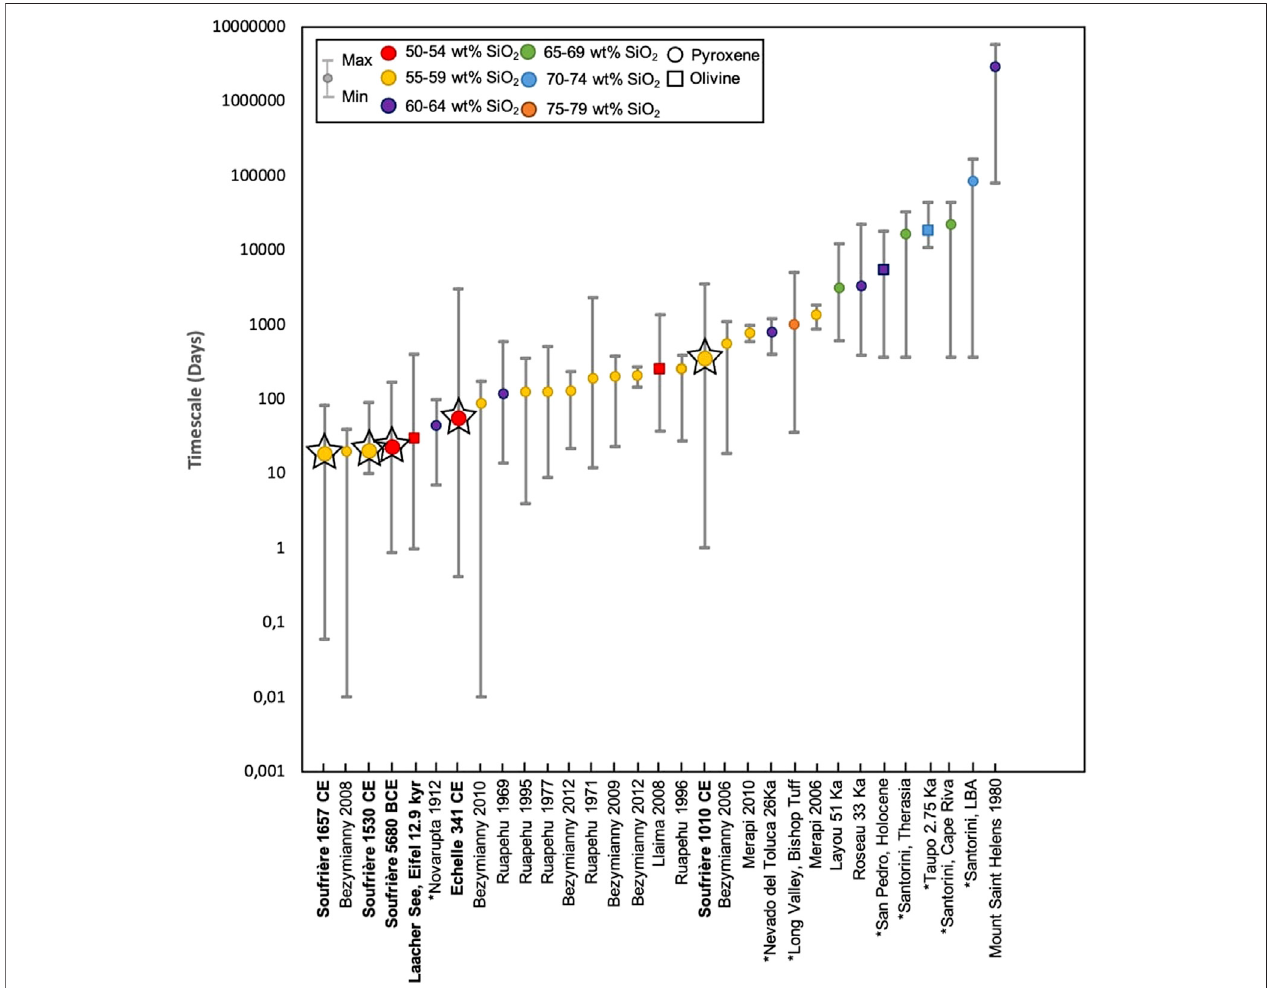
FIGURE 13 | Global database of diffusion timescales (adapted from Costa et al., 2020), for relatively evolved composition eruptions. The majority of studies are done on pyroxene with two examples of olivine studies. This shows the wide range of timescales that can be calculated through diffusion methods, from hours to centuries. Systems incomparable to La Soufriére are marked with an asterisk (*), these systems generally record the longest timescales and are more typically observed in evolved caldera forming systems. The1530 C.E., 1657 Cal. CE and 5680 Cal. BCE (whole rock estimated) eruptions record some of the shortest timescales for systems in a similar compositional range, with timescales most similar to Bezymianny and Novarupta, Alaska, which show similarly short timescales. (Davydova et al., 2018; Boudon et al., 2008; Pichavant et al., 2018; Singer et al., 2016; Ruth, et al., 2018; Costa et al., 2013; Weber et al., 2019; Chamberlain et al., 2014; Costa and Chakraborty, 2004; Fabbro et al., 2013; Barker et al., 2016; Flaherty et al., 2018; Kilgour et al., 2014; Gamble et al., 1999; Saunders et al., 2014; Fabbro et al., 2013; Bourgeoisat, 2018; Solaro et al., 2020; Sundermeyer et al., 2020).